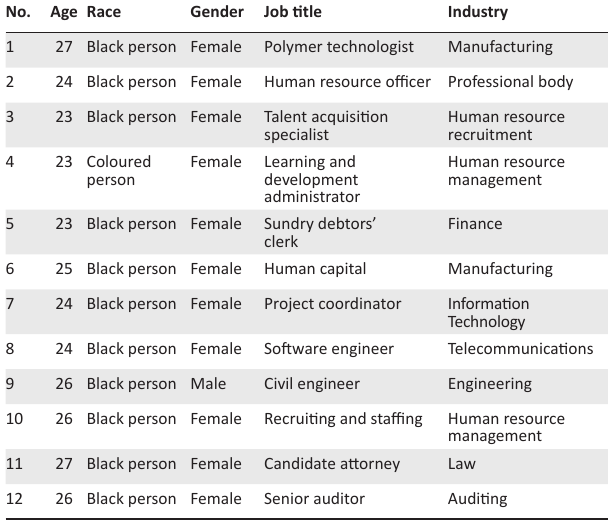
TABLE 1 : Summary of the sample biographic